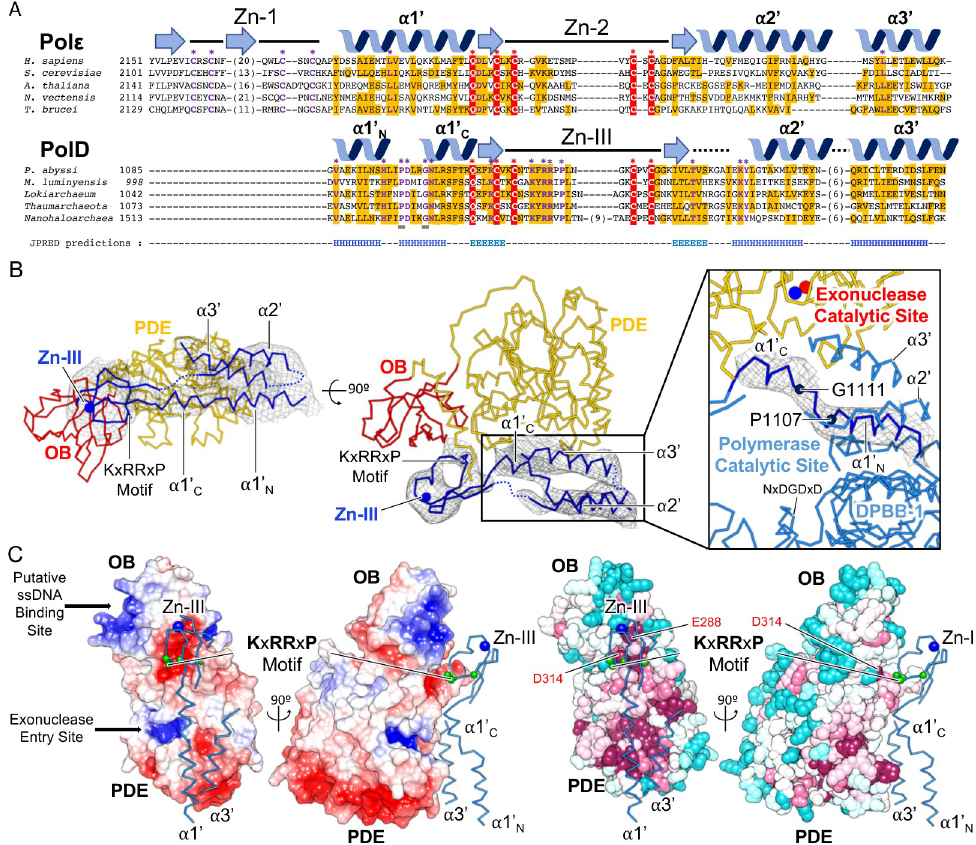
Fig 6. Structural basis for the interaction between DP1 and DP2. (A) Structure-based sequence alignment of the C- terminal regions of Homo sapiens Pol ε A subunit (PDB ID: 5VBN [24]) and P . abyssi PolD DP2. Secondary structure elements are shown above the sequence alignment according to the crystal structure of the H . sapiens Pol ε and the cryo- EM structure of PolD. Sequence similarity is highlighted with yellow boxes, and conserved residues are highlighted with red boxes. The “helix-breaker” motif is indicated with gray lines. Two connecting loops (1149–1155) and (1171–1777) were omitted because of the lack of density. Secondary structures predictions from Jpred [27] of the P . abyssi PolD DP2–CTD are shown below the sequence alignment. (B) Structure of the DP1/DP2-CTD interface. Density surrounding the DP2– CTD is shown in gray mesh and contoured at 6 σ . Disordered loops are indicated by dotted blue lines. The right panel shows an enlarged view of the cryo-EM density that surrounds the α 1’ N and α 1’ C helices. (C) Overall view highlighting the contribution of the DP2 C helices α 1’ and α 3’ and the Zn-III binding domain to the DP1–DP2 interface. DP2–CTD is shown as ribbon, and the Zn 2+ ion is represented as a blue sphere. C α atoms of the KxRRxP motif contained in the Zn-III binding domain are shown as green spheres. Left: Charge distribution at the interface of the DP1–DP2 complex. Electrostatic surface potentials are generated using the DP1 H451A crystal structure (PDB ID: 6HMF, this study) fitted into the cryo-EM density. Right: Same view showing the evolutionary conservation of the surface amino acids mapped on DP1, calculated with Consurf [37] from an alignment of 150 DP1 sequences. Amino acid conservation is indicated by a transition in color hues, from magenta (most conserved) to cyan (most variable). cryo-EM, cryo–electron microscopy; CTD, C-terminal domain; DPBB, double-psi β -barrel; OB, oligonucleotide binding; PDB, Protein Data Bank; PDE, phosphodiesterase domain; ssDNA, single-stranded